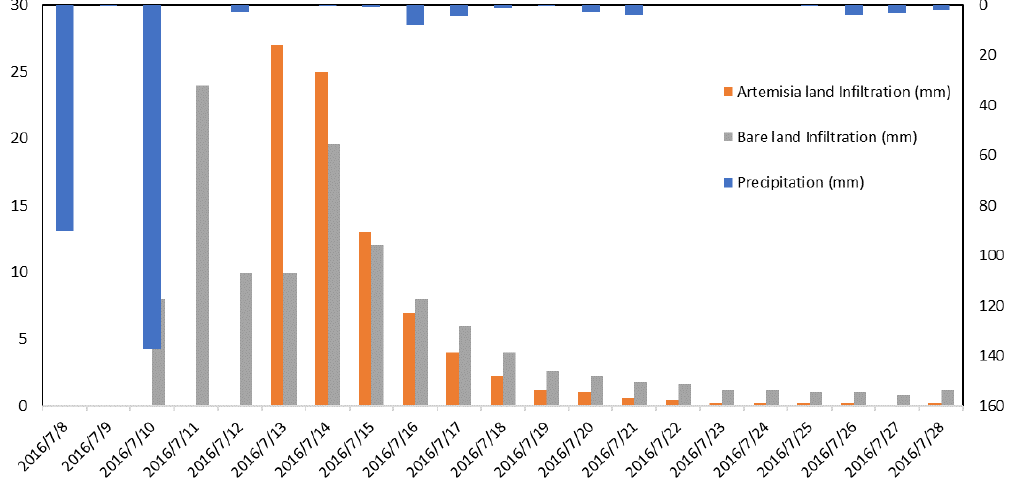
Figure 8. DSR response to precipitation on the bare sandy plot and ASK